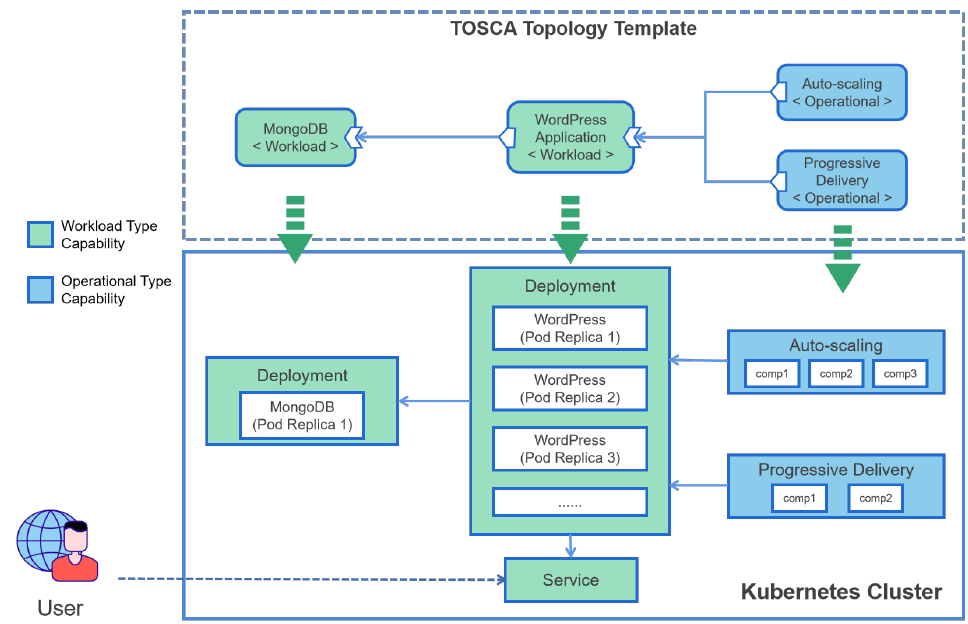
Figure 4. WordPress cloud application in